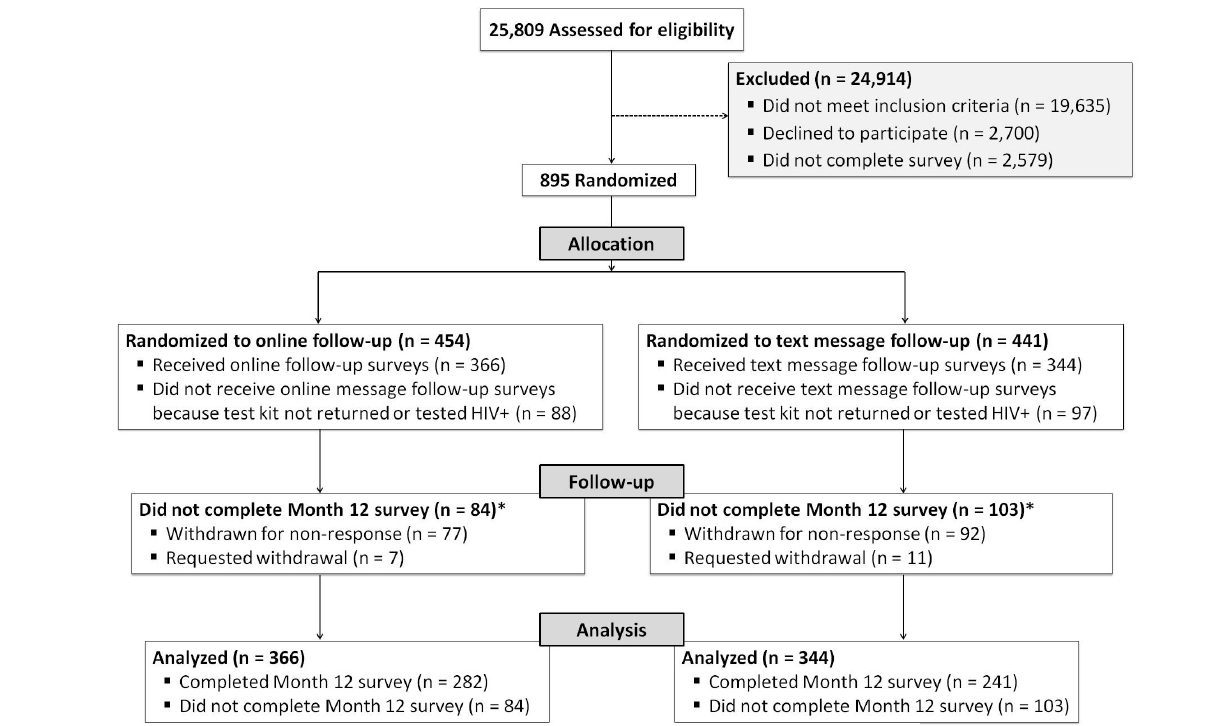
Figure 1. Enrollment of study participants in a 12-month prospective online